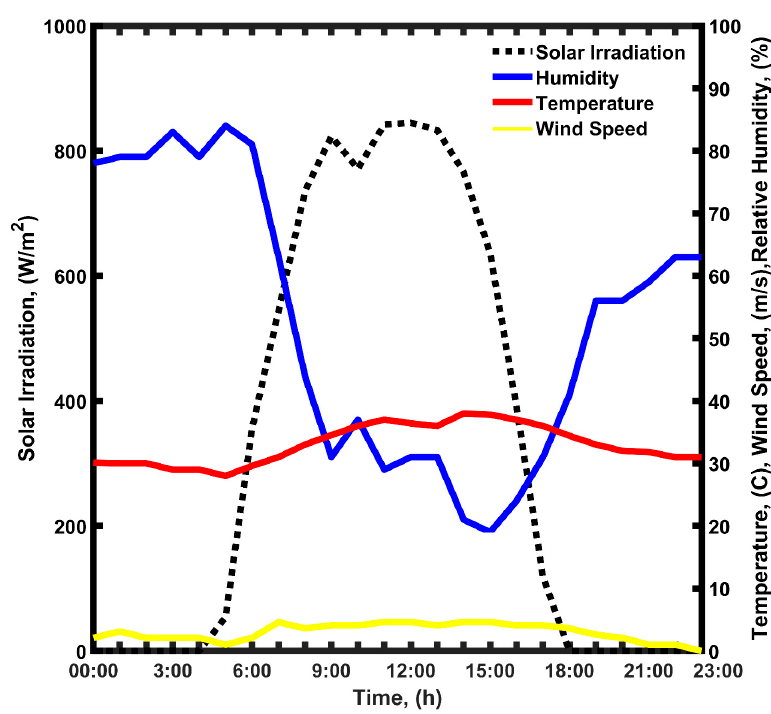
Figure 2. 24 h weather data profile on 21 June at Doha, Qatar.